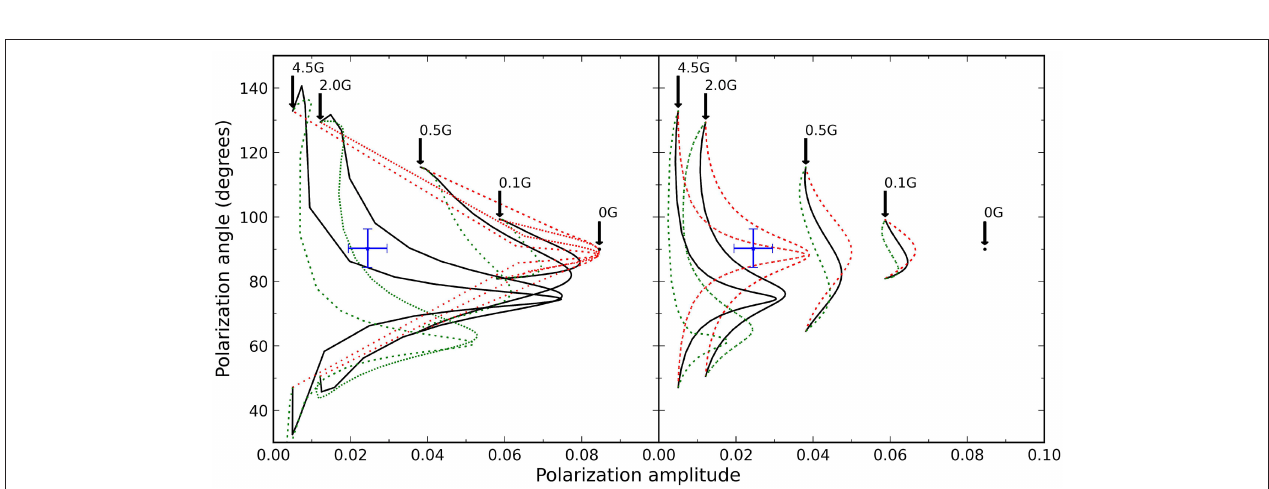
FIGURE 6 | The same as Figure 5 but for the Field II model grids and corresponding errors. The SiX1430 linear polarization signal for Field II is weak and thus relatively uncertain for the selected realistic measurement accuracy. This uncertainty leads to the large distortions in the model grids. High accuracy forbidden line polarization directions will be required in this